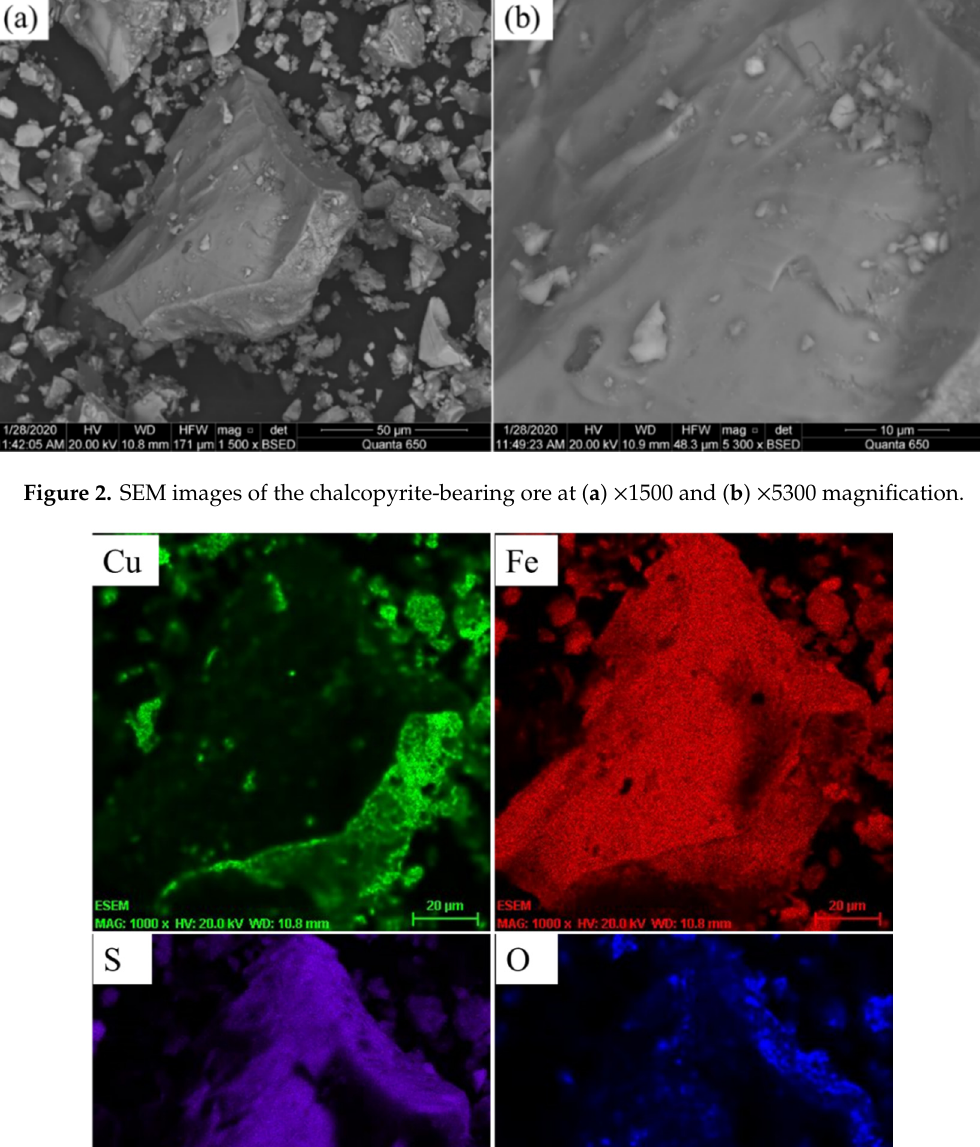
3 of 16 Figure 1. X-ray diffraction pattern of the chalcopyrite-bearing ore sample. Table 1. Chemical composition of chalcopyrite from inductively coupled plasma optical emission spectrometry. Chalcopyrite